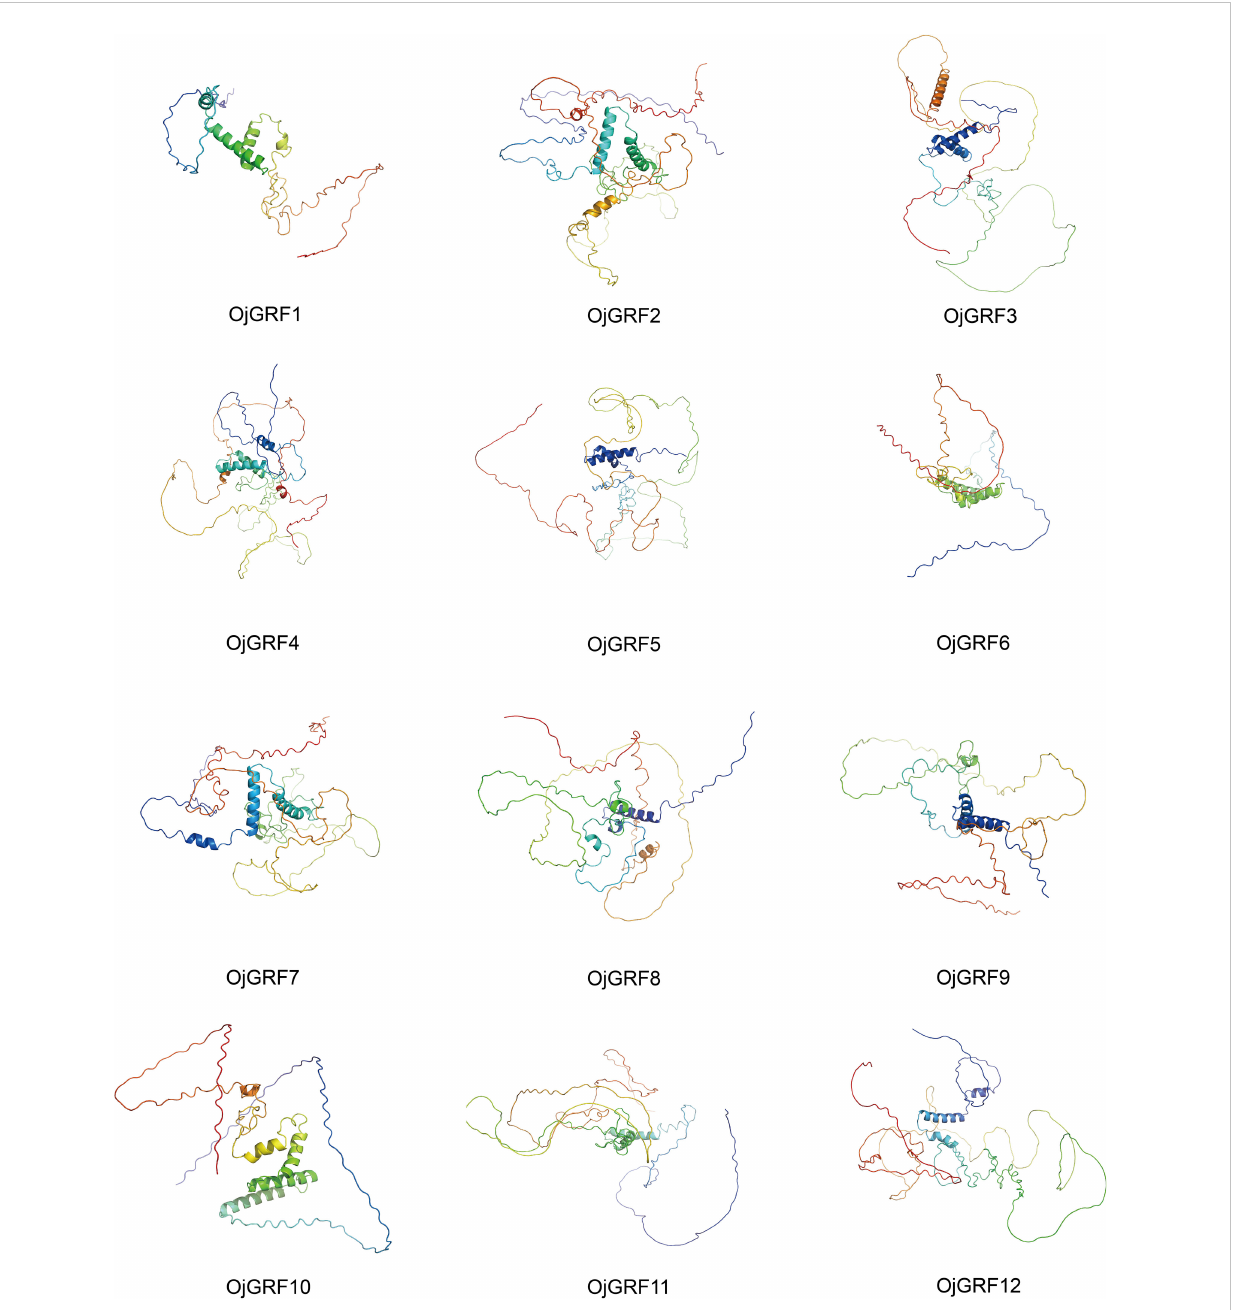
FIGURE 5 Prediction of the three-dimensional structure of GRFs protein in rice. The three-dimensional structure of 12 GRFs protein in rice was predicted by using the Alphafold2, and the results were output by PyMol